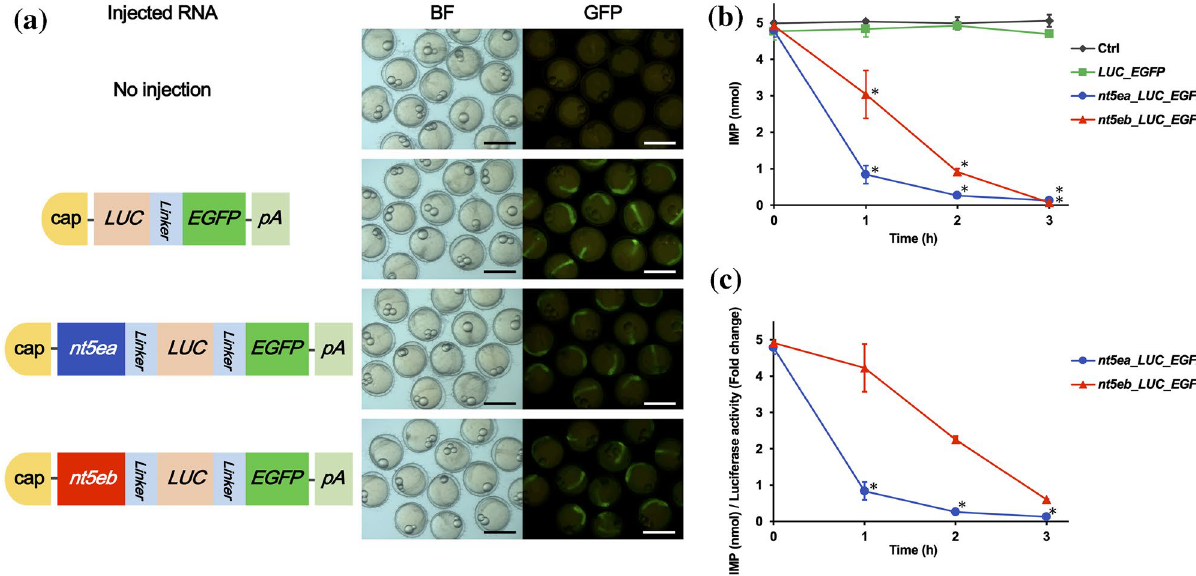
Figure 3. Assay of inosine monophosphate (IMP)-degrading activities of Nt5ea and Nt5eb. ( a ) Representative GFP expression in embryos at 1 d post fertilization. Green fluorescence was detected from embryos injected with RNA encoding LUC - EGFP , nt5ea - LUC - EGFP , or nt5eb - LUC - EGFP , but not from embryos without microinjection. BF bright field, GFP green fluorescent protein, scale bar 1 mm. ( b ) IMP degradation via overexpression of nt5ea and nt5eb . Embryos without microinjection were used as a control (Ctrl). Data are presented as the mean ± SD of three determinations with different enzyme preparations. The asterisks indicate that the values are significantly different to those of the Ctrl group according to one-way ANOVA followed by Tukey’s HSD test. * P < 0.05. ( c ) Comparison of IMP-degrading activities between Nt5ea and Nt5eb after normalization with LUC luminescence. The asterisks indicate that the values of the group nt5ea - LUC - EGFP were significantly less than those of the group nt5eb - LUC - EGFP according to one-way ANOVA followed by Tukey’s HSD test. * P <